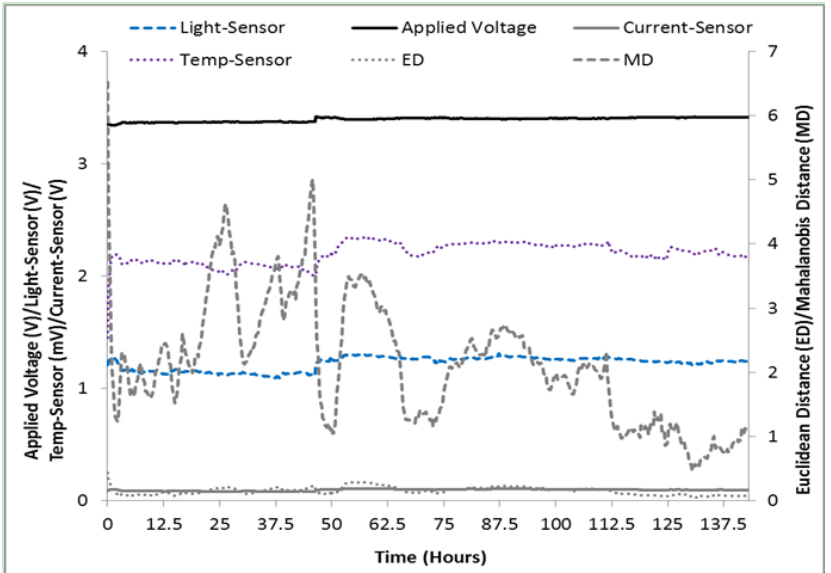
Figure 9. Sensor data for normal operating conditions.